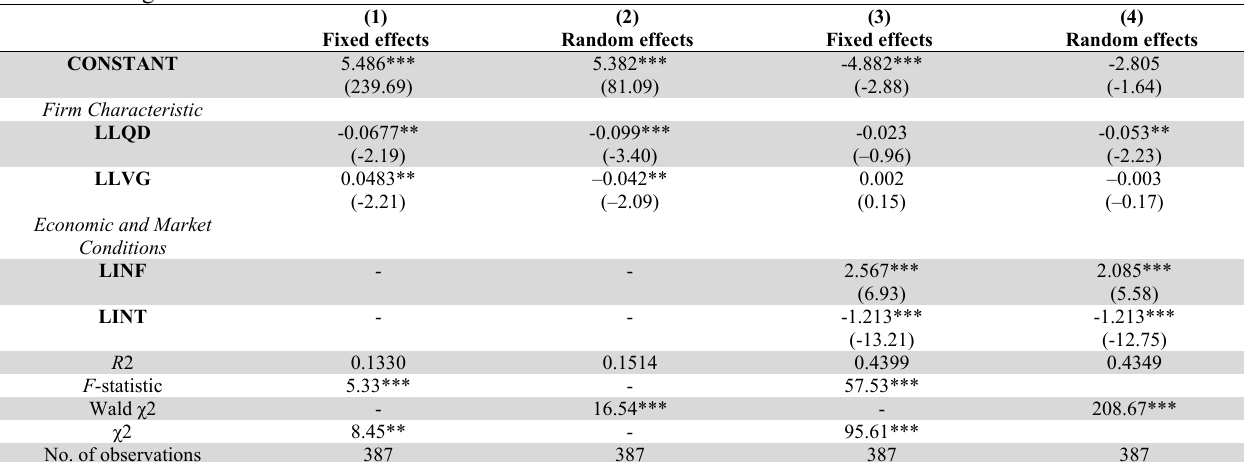
Multivariate regressions